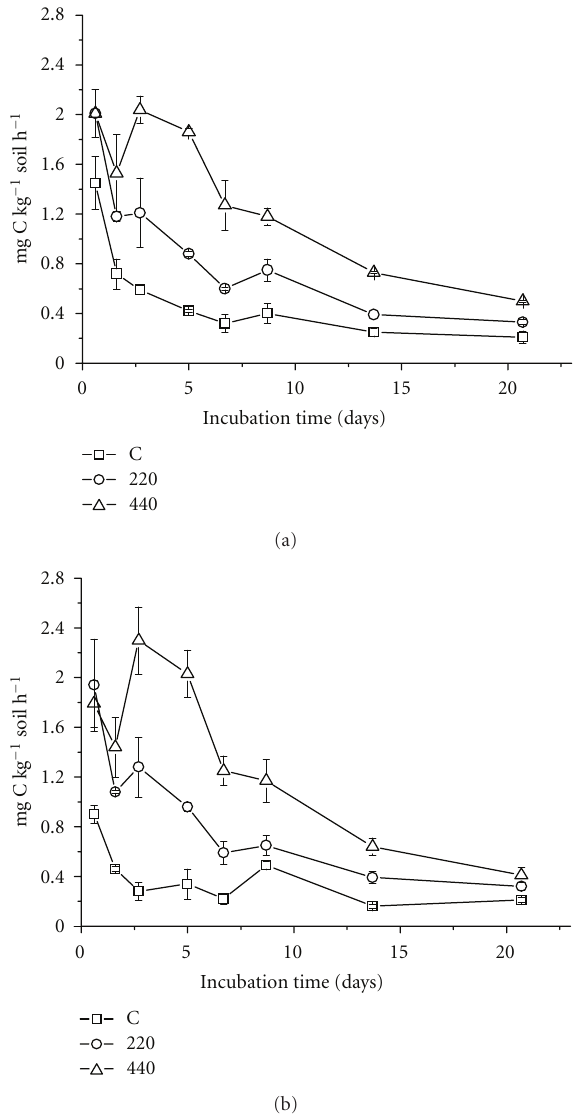
Figure 3: Dynamics of CO 2 -C evolution rate in soil M (a) and soil P (b) at di ff erent sampling time. C: controls; 220: TLP addition rate at 220 kg N ha − 1 ; 440: TLP addition rate at 440 kg N ha − 1 ; bars represent standard deviation ( n =